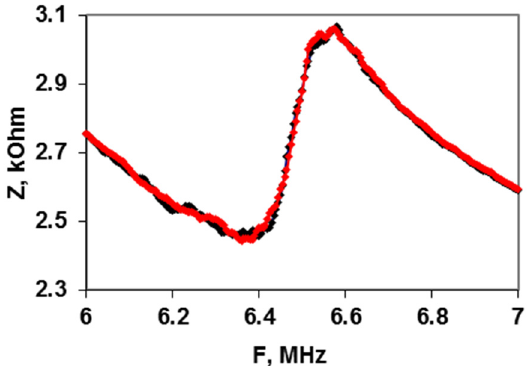
Figure 10. The frequency dependences of the electrical impedance module Z for distilled water before (black line) and after (red line) adding CAP of 10 μ g/mL.